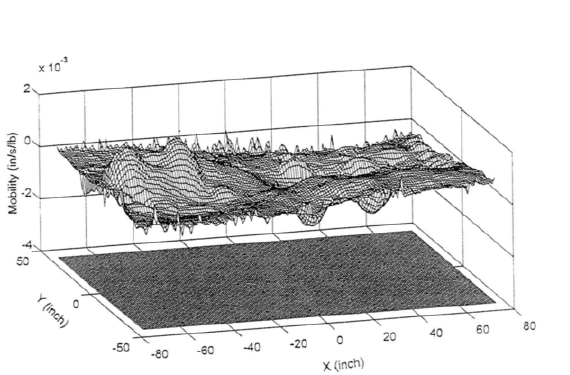
FIGURE 6 The remapped evenly spaced mobility data (68 x 158, real part) for the same data in Fig.